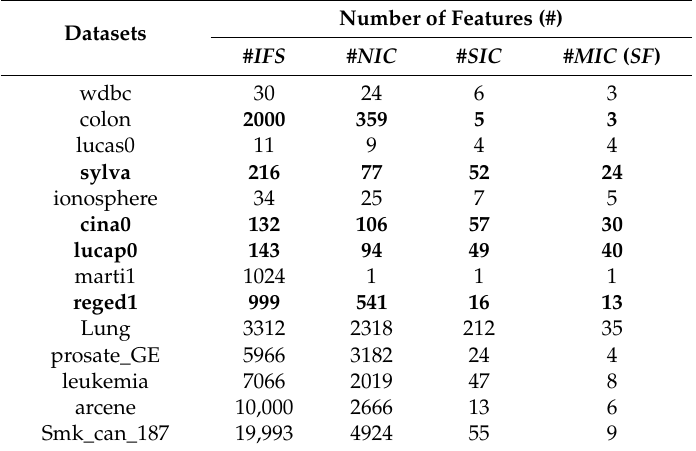
Table 4. The number of features in filtering conditional